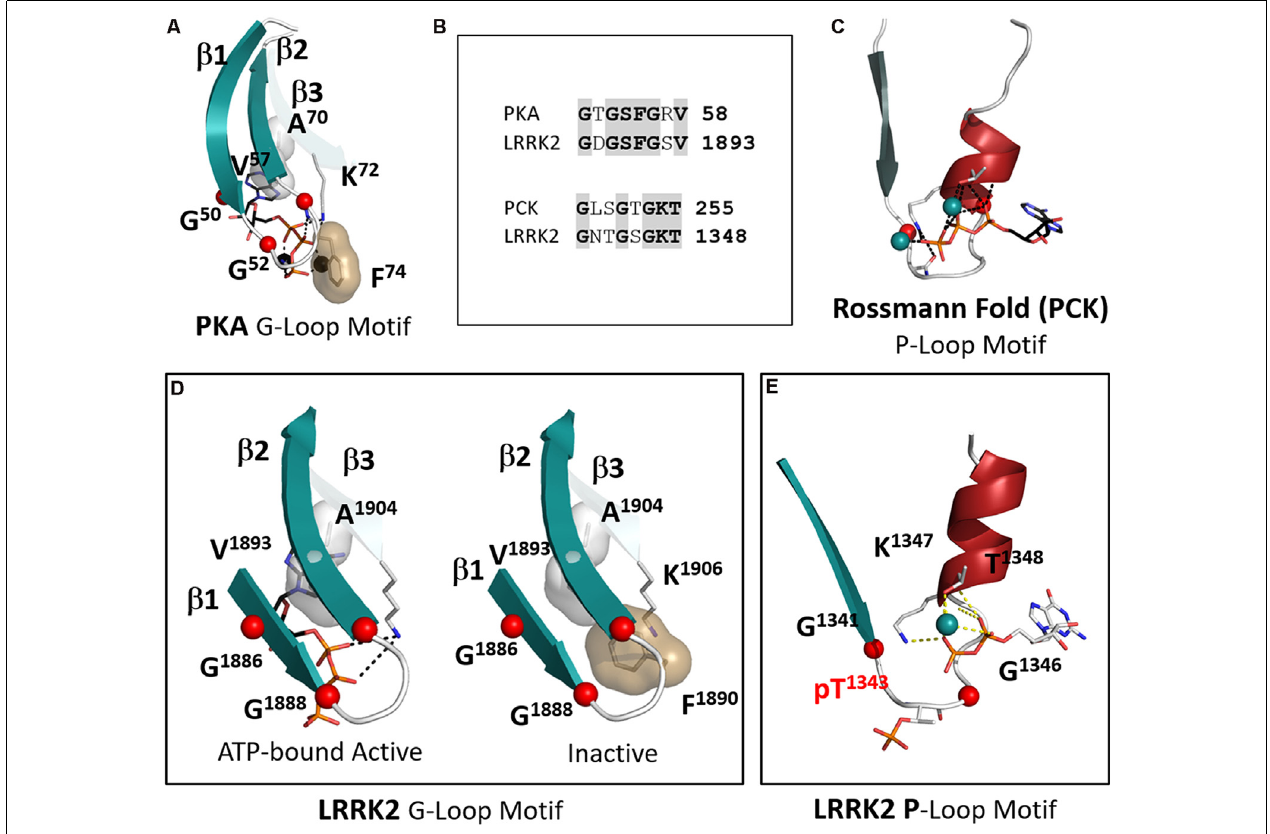
FIGURE 7 | The P-Loop and G-Loop of LRRK2. (A) The canonical G-Loop found in all kinase domains. The adenine ring is buried under the first three β -strands with Alanine in β -strand 3. Valine in β strand 2 being highly conserved C-spine residues that cap the upper surface of the adenine ring. (B) The sequences of the G-Loop in PKA and LRRK2 are aligned at the top and the sequences of the P-Loop of phosphoenolpyruvate carboxykinase (PCK) and LRRK2 are aligned at the bottom. (C) The canonical P-loop first described by Rossmann (Ramakrishnan et al., 2002). Although it is also associated with ATP binding the architecture of this loop is distinct from the G-Loop. The Glycine-rich loop is preceded by a beta-strand as in the G-Loop, but it is then followed by a helix that contains the conserved Lysine. The nucleotide is positioned typically on the surface of the protein while the γ -phosphate of ATP is buried under the loop. (D) The G-Loop of LRRK2 conforms to this canonical architecture. Two conformations are shown in the box: on the left is a model with ATP-bound; on the right is the apo structure (Deniston et al., 2020). (E) LRRK2 has a canonical P-loop in the ROC domain that binds to GTP/GDP. In the RCKW structure, GDP is bound and the loop contains a phosphorylated Threonine (T1343). The conserved glycines are shown as red